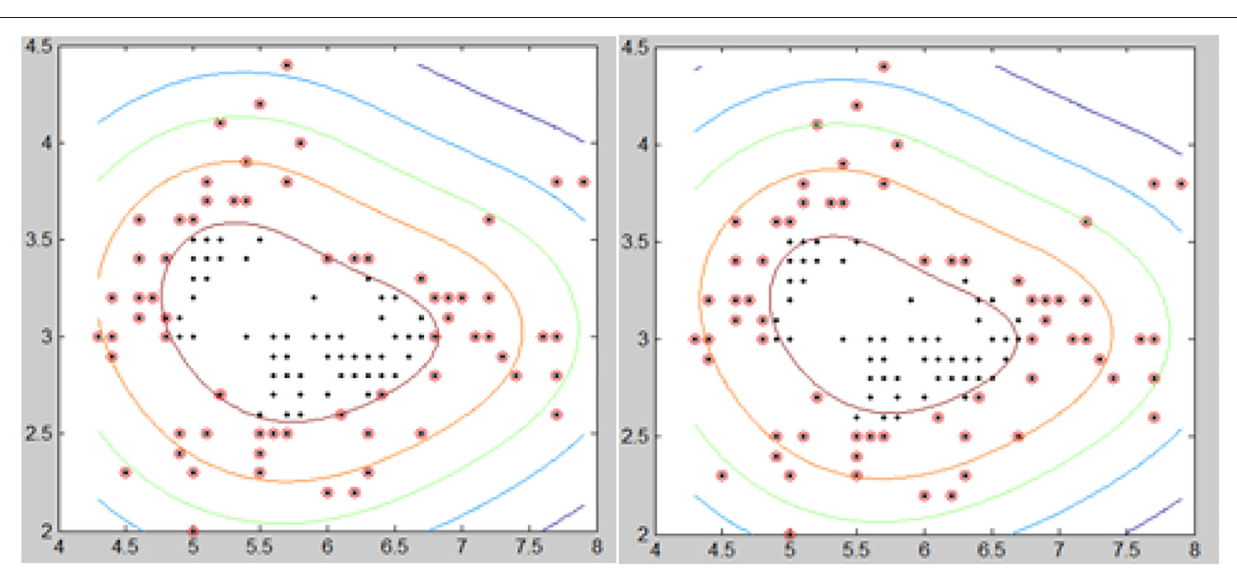
FIGURE 8 | BEC kernel (Left) and Gaussian kernel (Right) for Fisheriris